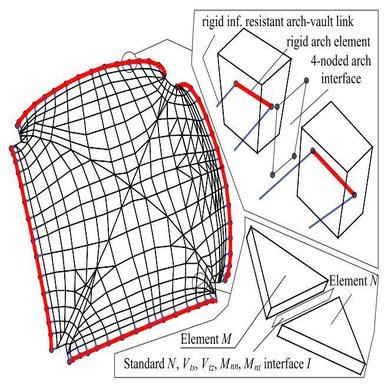
Details of the inelastic interfaces in the RBS approach.